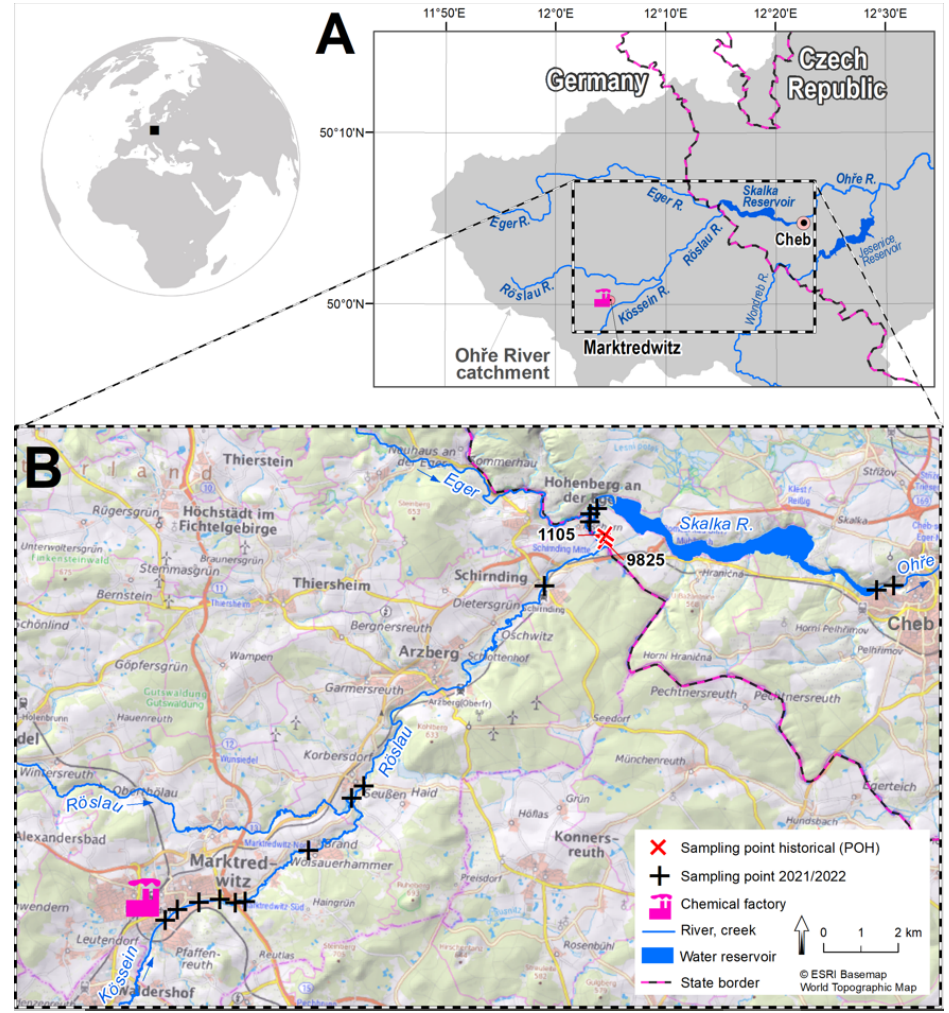
Figure 1. Map of the Oh ř e River catchment ( A ) and detailed map of the study area with position of sampling sites ( B ).